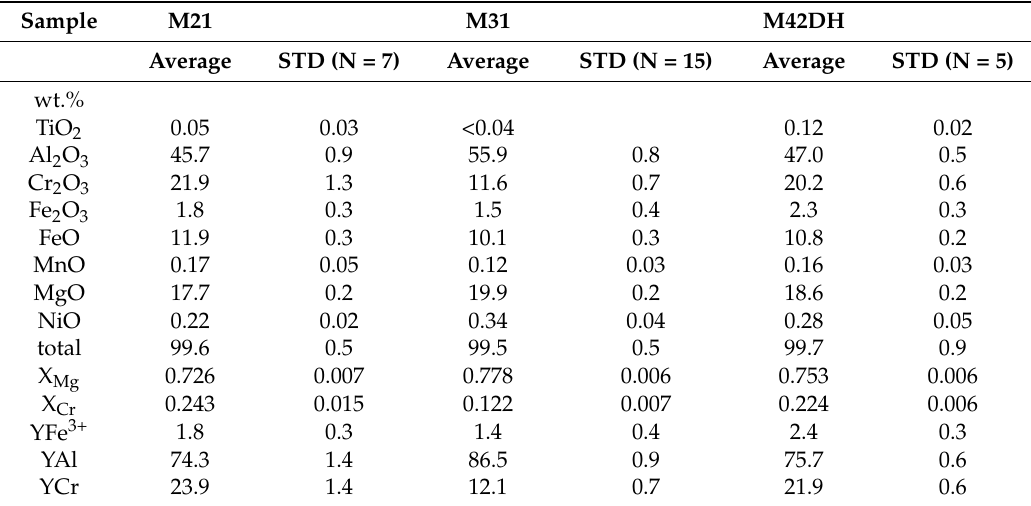
Table 2. Representative spinel